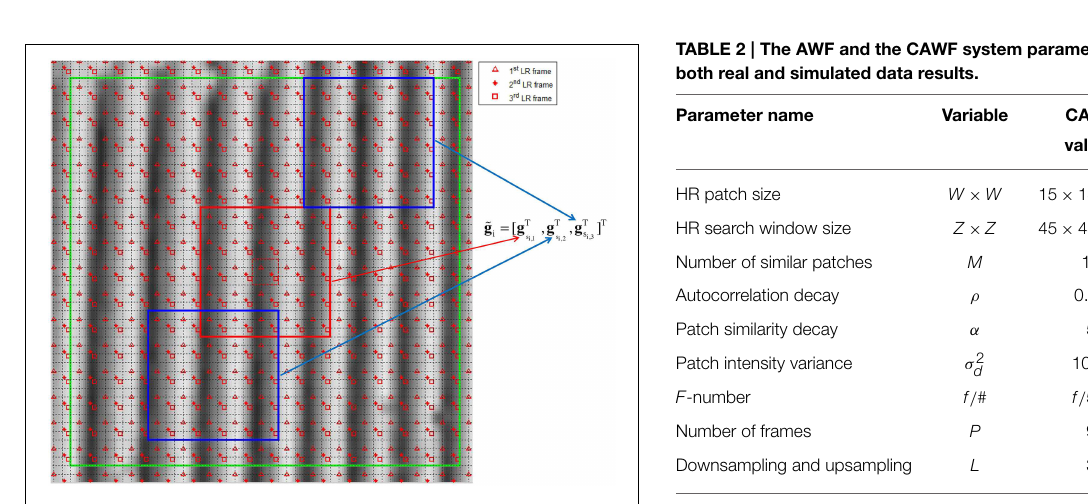
FIGURE 3 | The HR grid shows the LR pixel locations for three frames (triangular, star, and square). The large green box represents the searching TABLE 3 | Imaging Source camera (DMK 23U618) window span ( 45 45 HR pixels).The red box represents the reference patch × while the blue ones represent its similar (each one is 15 15 HR pixels). The × small dashed red box represents the estimation window ( 3 3 HR pixels) ×